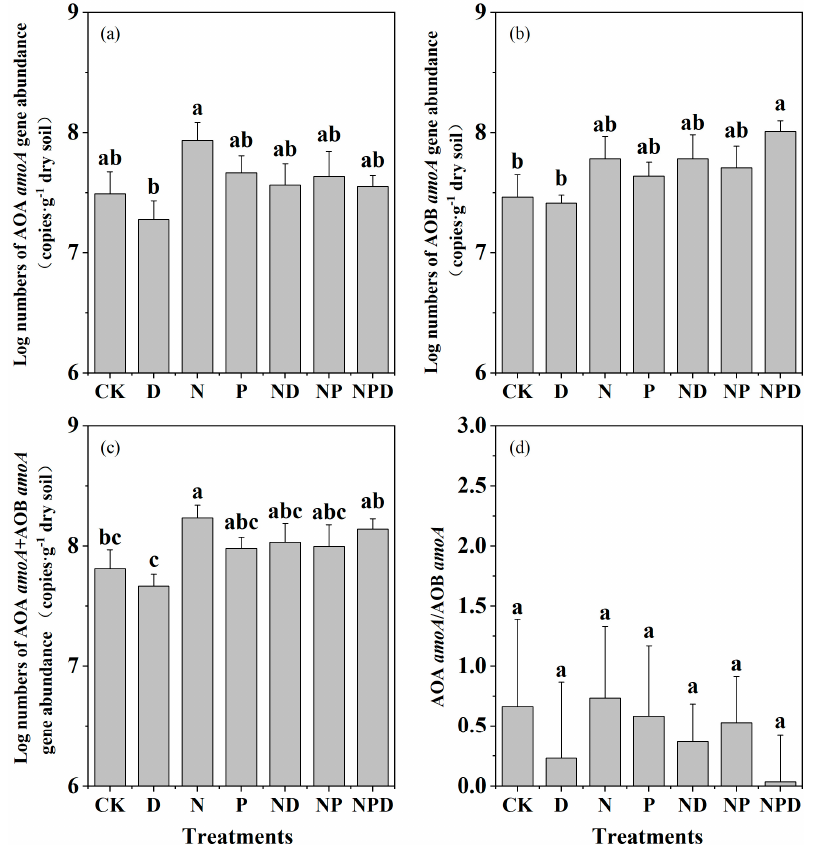
Figure 1. Effects of different treatments on the abundances of the ( a ) AOA amoA gene; ( b ) AOB amoA gene; ( c ) AOA amoA gene + AOB amoA gene; and ( d ) AOA amoA /AOB amoA . Note: Data are presented as the mean ± SE (n = 4). Different letters above boxplots indicate significant differences ( p < 0.05) between treatments. Treatments: control (CK), drought (D), nitrogen addition (N), phosphorus addition (P), nitrogen and drought combined (ND), nitrogen and phosphorus combined (NP), and nitrogen, phosphorus, drought combined (NPD).